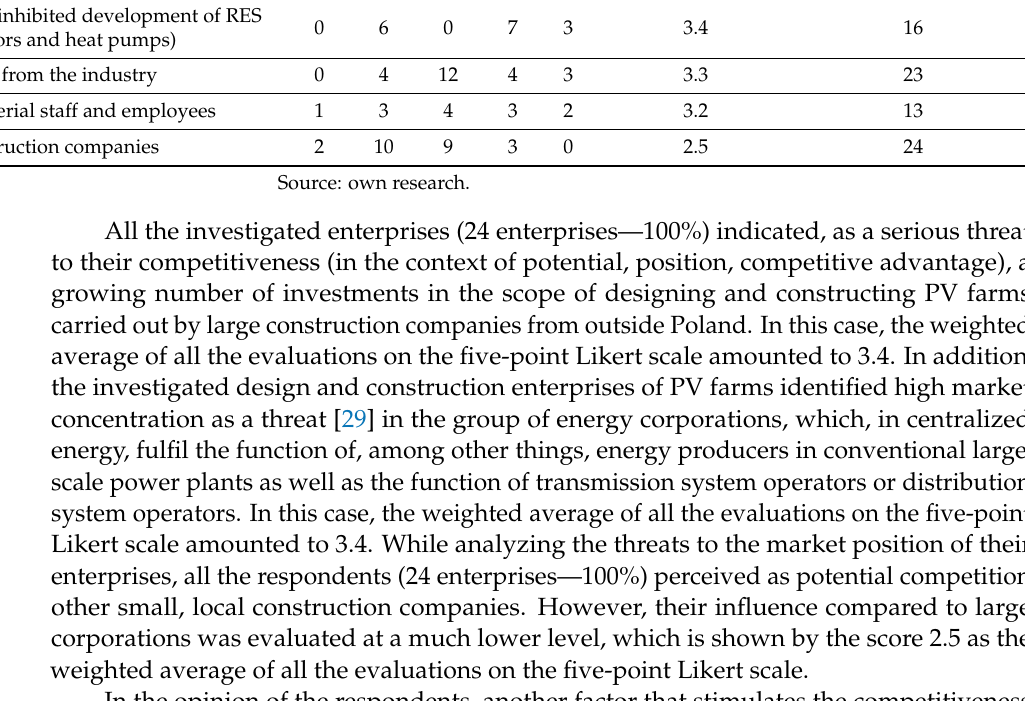
Factors That Stimulate Enterprise’s Competitiveness